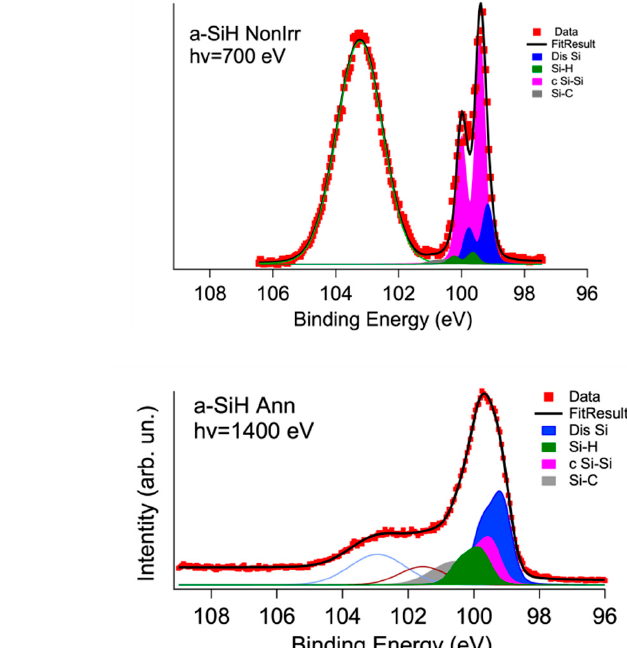
Figure 3. Si 2p core level for the reference a-Si:H (a-Si:H Ref) sample measured at 1400 eV photon energy and the deconvolution into chemically shifted components (see also Table 1).